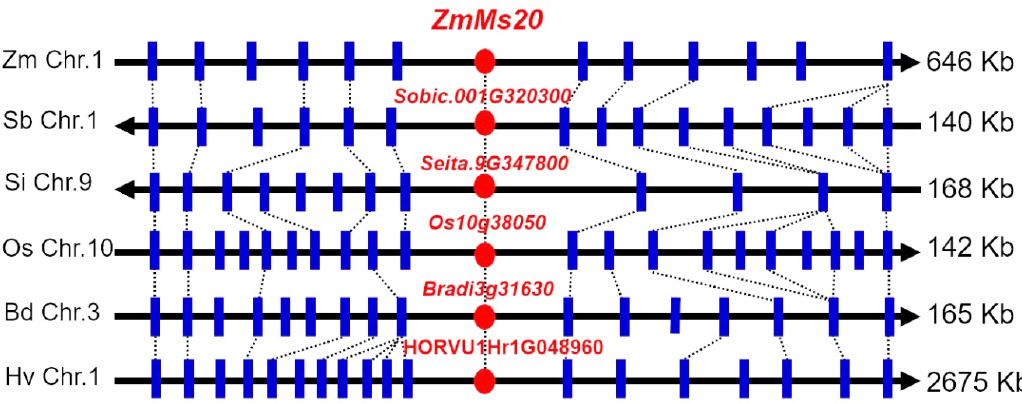
Figure 4. Microsynteny comparison of maize ZmMs20 locus with its orthologs in five other monocot species. Microsynteny comparison of maize ZmMs20 locus with its ortholog counterparts from Brachypodium distachyon (Bd), Hordeum vulgare (Hv), Oryza Sativa (Os), Sorghum bicolor (Sb), and Setaria italica (Si). The red solid circles indicate ZmMs20 and the orthologous genes, and the blue solid vertical lines indicate the genes flanking ZmMs20 or the orthologous genes. The arrows indicate direction of the chromosomes (Chr.), and each gene in the flanking region was given a serial number (Refer to Table S2). The spanning region length between two loci was shown without equal proportion, and total length (kilobase, kb) of the ortholog region was shown on the right.